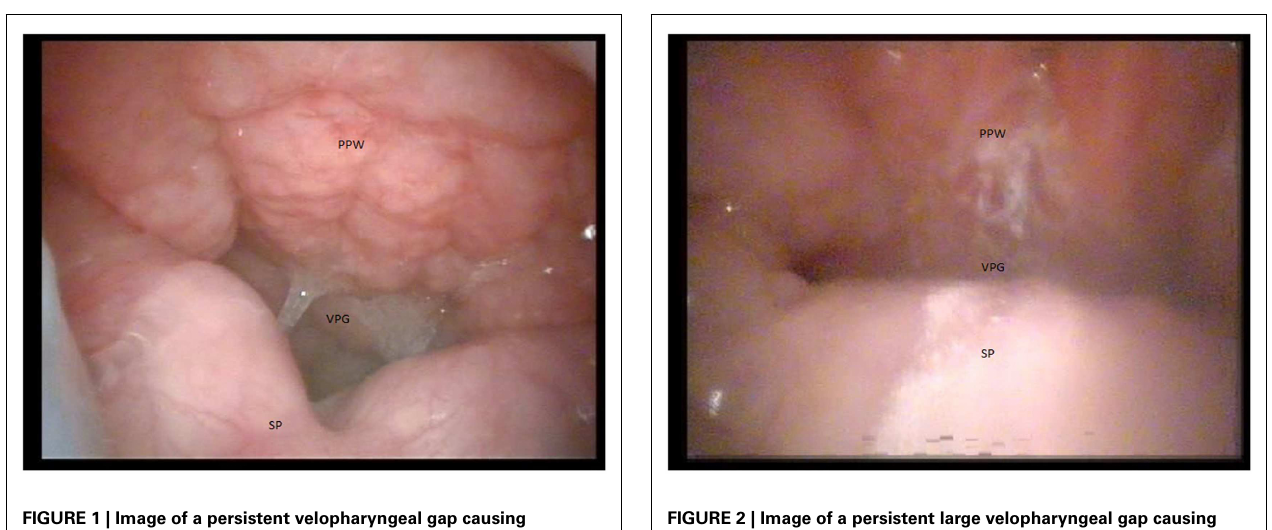
FIGURE 1 | Image of a persistent velopharyngeal gap causing velopharyngeal insufficiency in a patient with a submucous cleft palate undergoing video nasopharyngeal endoscopy (PPW = posterior pharyngeal wall,VPG = velopharyngeal gap, SP = soft palate) .